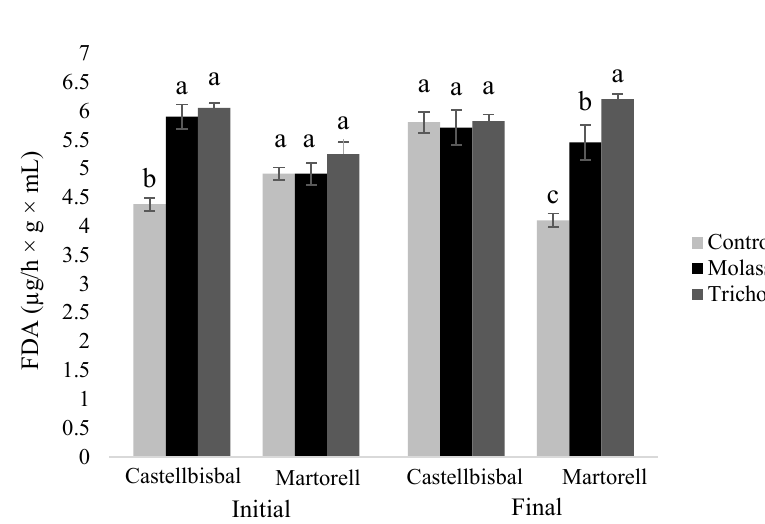
Data are presented as mean ± standard error of 5 repetitions for nematode densities, 20 for galling index and nematode reproduction in tomato, and 40 for galling index and 5 for nematode repro- duction in lettuce in Castellbisbal and 4 for nematode densities, 16 for galling index and nematode reproduction in tomato, and 36 for galling index and 4 for nematode reproduction in lettuce in Martorell. Data of each parameter in the same column followed by different letters indicates dif- ferences between treatments according to the Krustal–Wallis test ( p < 0.05). * Tomato: Eggs + J2 plant −1 ; Lettuce: Egg + J2 g root −1.